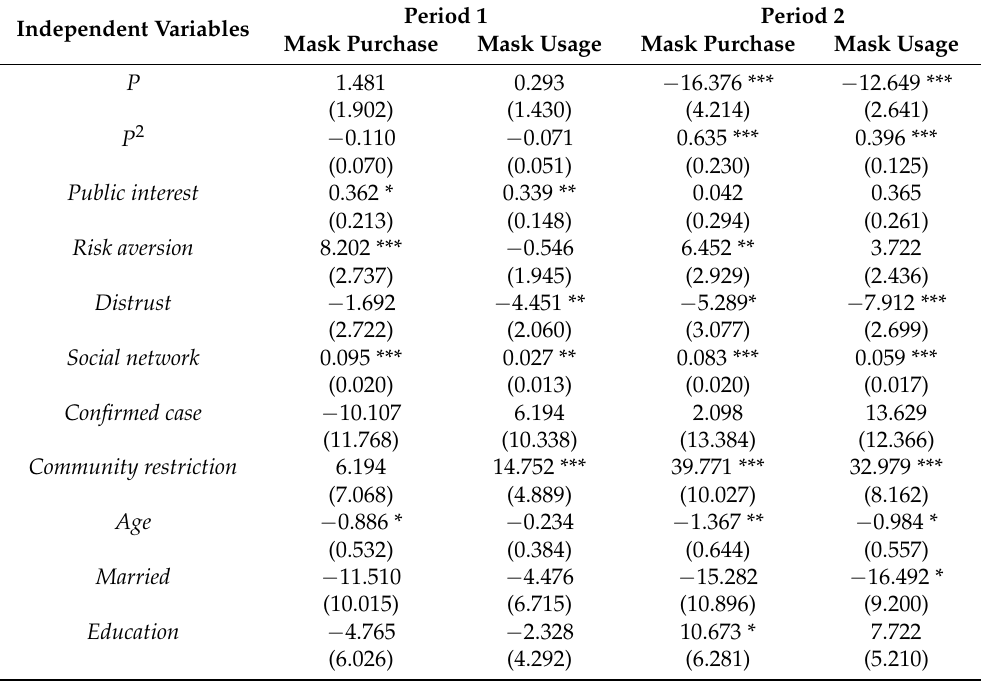
Table 2. Tobit regression results for Period 1 and Period